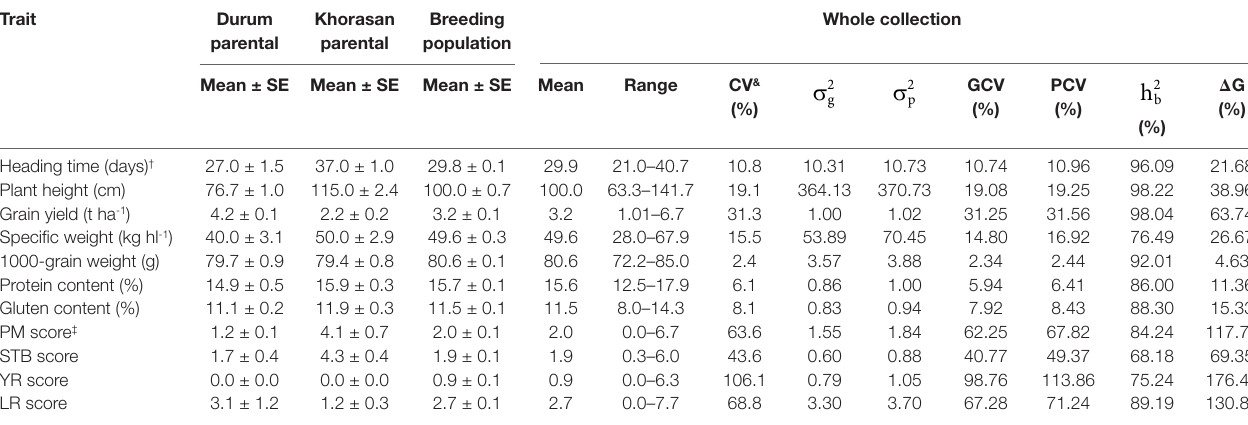
TABLe 4 | Phenotypic performance and estimates of genetic parameters of the 11 agronomic and disease-resistance traits in the parent lines and in the breeding population derived from the T. durum × T. turanicum crossing. Trait Durum